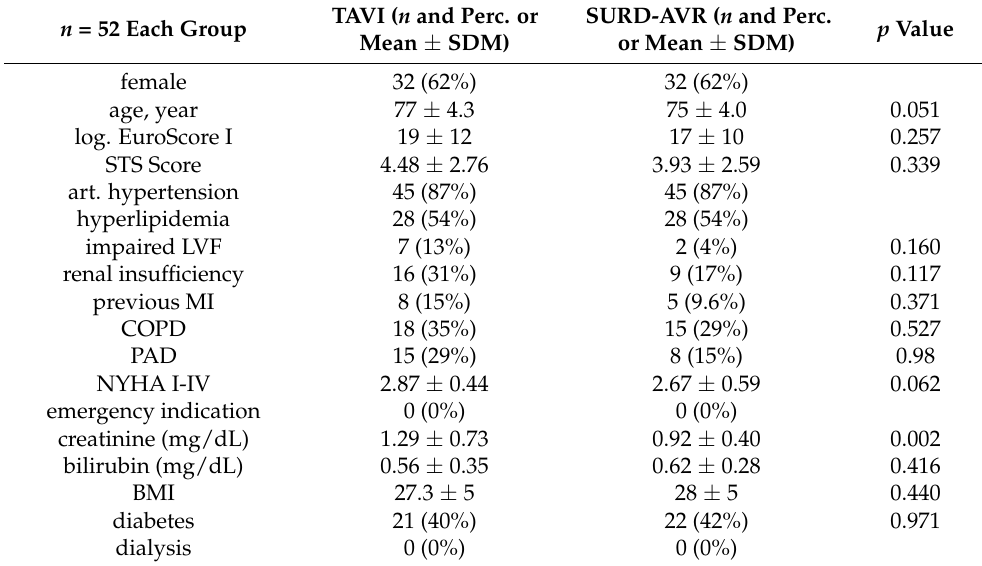
Table 1. Baseline